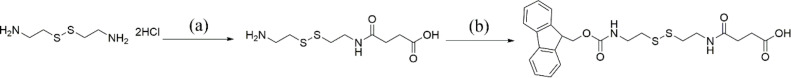
Synthetic route of Linker (Fmoc-cystamine succinic acid) for solid phase peptide. (a) Succinic anhydride, NaHCO3, 1,4-Dioxane/H2O, 0 °C; (b) Fmoc-OSu, DMF, 0 °C.